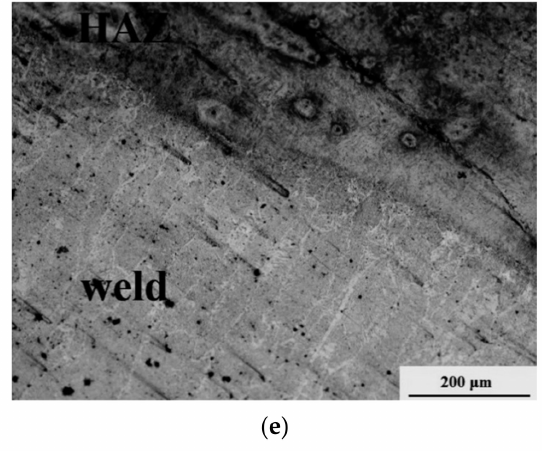
Figure 6. Optical micrographs of: ( a ) specimen 1 (non-modified electrode); ( b ) specimen 2 (underwater electrode); ( c ) scheme 3 (concrete impregnate); ( d ) specimen 4 (liquid foil); ( e ) specimen 5 (paraffin